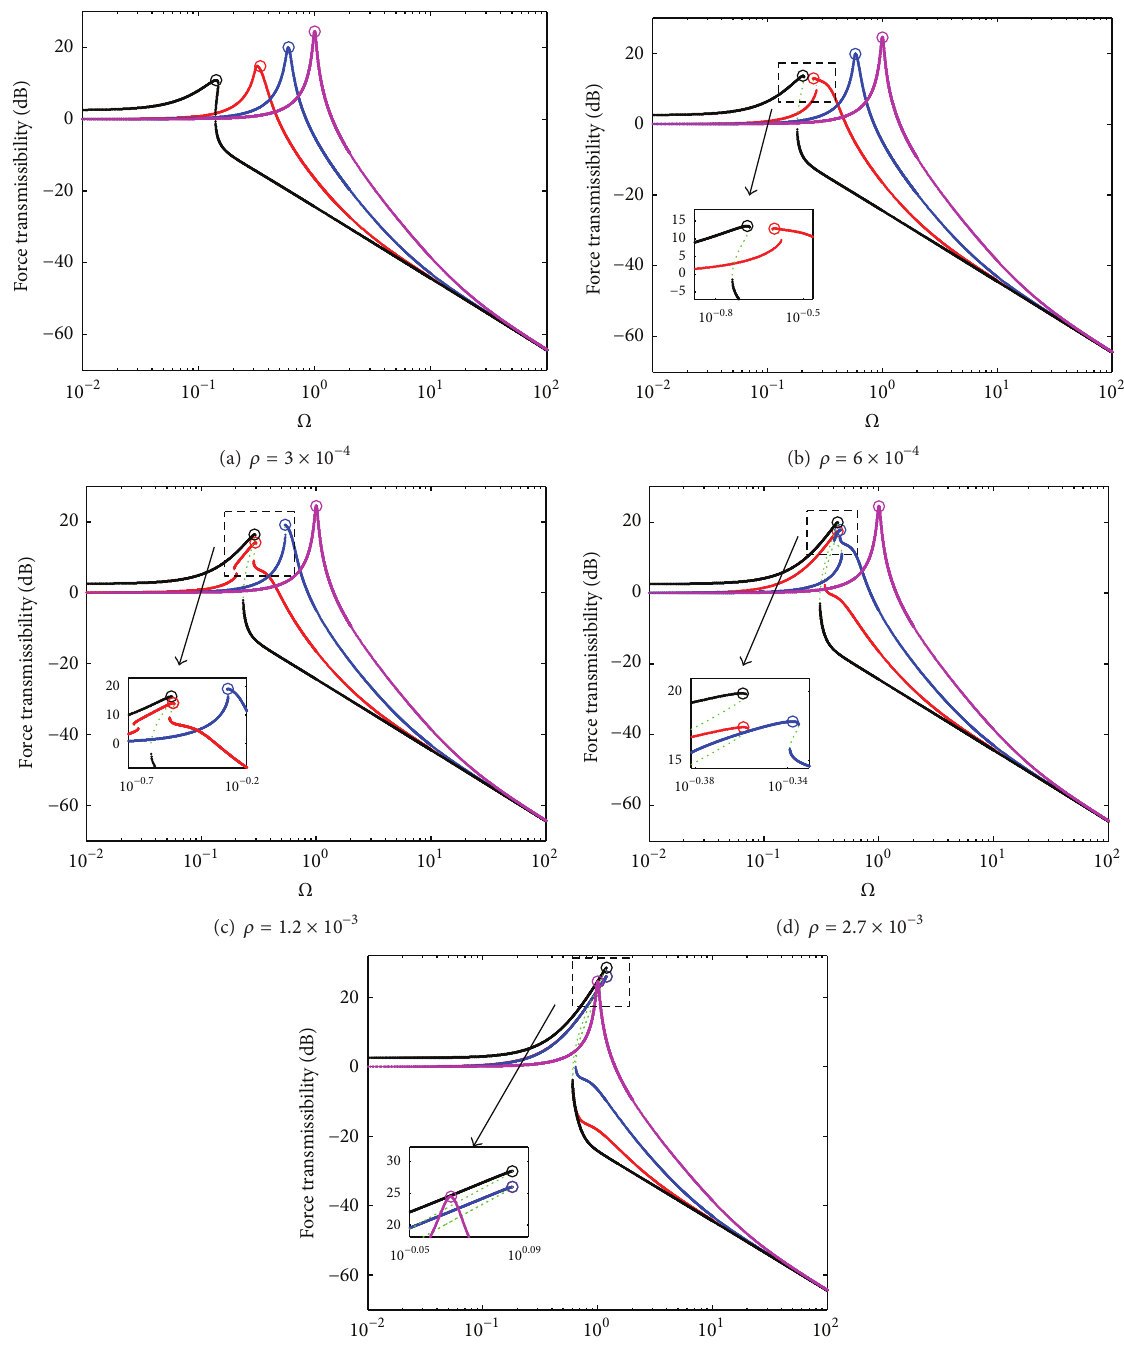
Figure 13: Force transmissibilities of QZS isolator and ELS with different offset displacements and excitation amplitudes for the force excitation. “Red line” the disturbed isolator with ̂𝑢 0 = 0.04 ; “blue line” the disturbed isolator with ̂𝑢 0 = 0.07 ; “black line” the ideal isolator; “magenta line” ELS; “green dotted line” unstable solutions; “o” peak amplitude of